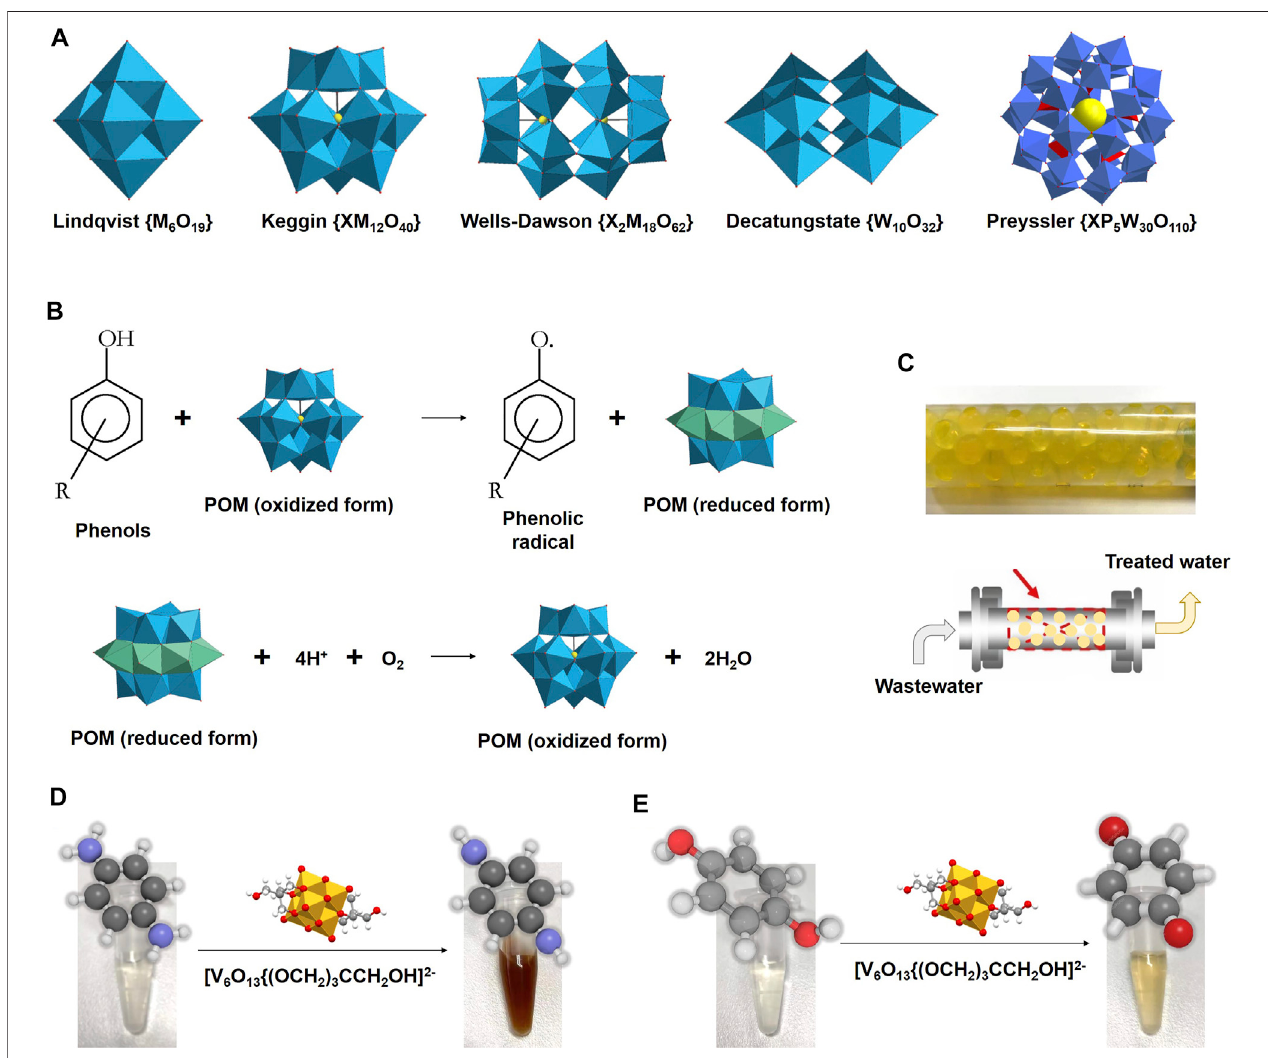
FIGURE 2 | (A) Conventional types of polyoxometalates (M = Mo, W, V, Nb; X = heteroatom). (B) Scheme of degradation of phenolic contaminants by laccase- mimicking POMs. (C) Scheme of a batch reactor with POV hybrid as a quasi-homogeneous catalyst for degradation of emergent water contaminants. Scheme of laccase-like catalytic activity of POV hybrids for oxidating p -phenylenediamine (D) and hydroquinone (E) .